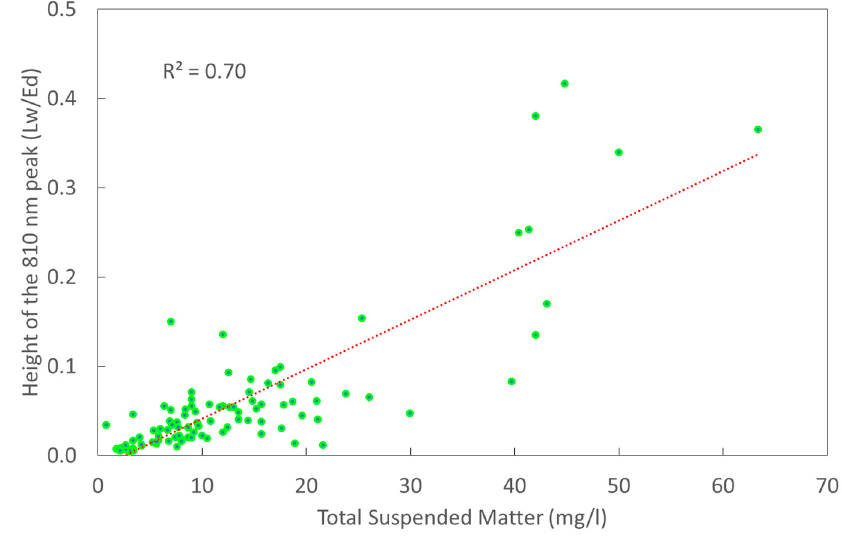
Figure 6. Correlation between the 810 nm peak height (P 2 , Equation (2)) and total suspended matter concentration in all Estonian and Swedish lakes.